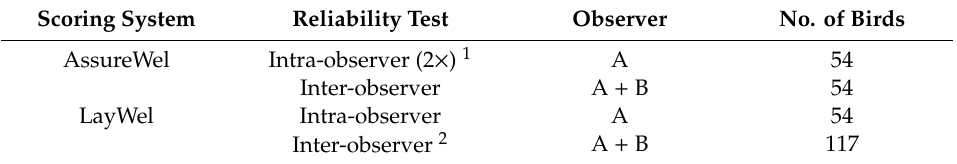
Table 1. Procedures for assessment of intra- and inter-observer reliability of feather damage (FD) scoring in laying hens based on two existing scoring systems using numeric scales (LayWel, 1–4 scale and AssureWel, 0–2